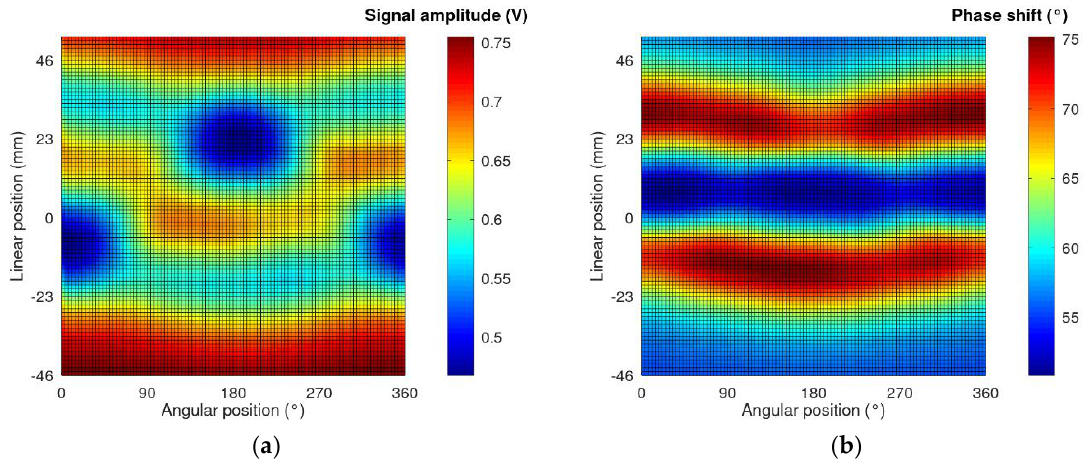
Figure 3. Exemplary measurement results for the sample with an 8 mm wide insertion cut. ( a ) Results of the signal amplitude as a function of the sample position; ( b ) results of the phase shift between the excitation and measured signals as a function of the sample position.